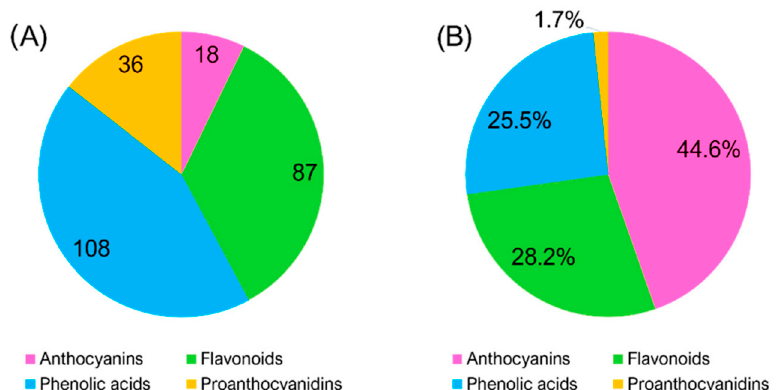
Figure 1. Pie chart reporting the tentatively identified classes of compounds in terms of ( A ) num- ber of identifications and ( B ) total peak area. of identifications and ( B ) total peak